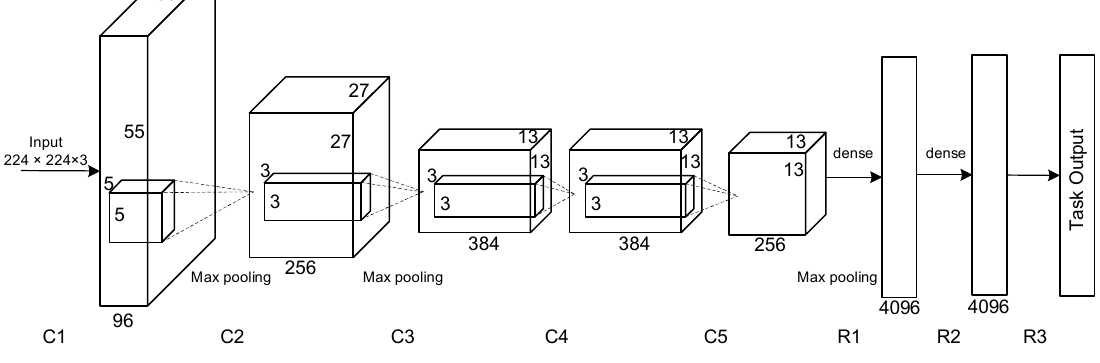
Figure 9. The architecture of the multi-task deep network.